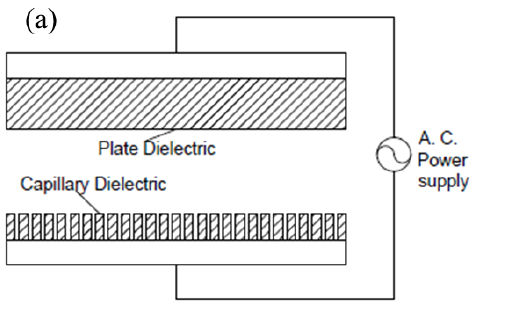
Figure 2. Schematic of capillary plasma electrode configuration: ( a ) single capillary dielectric layer; ( b ) double capillary dielectric layer.